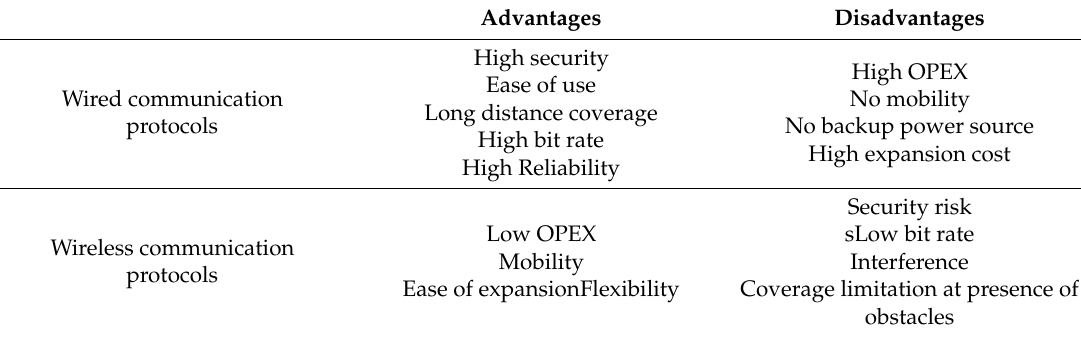
Table 3. Comparison of wired and wireless communication